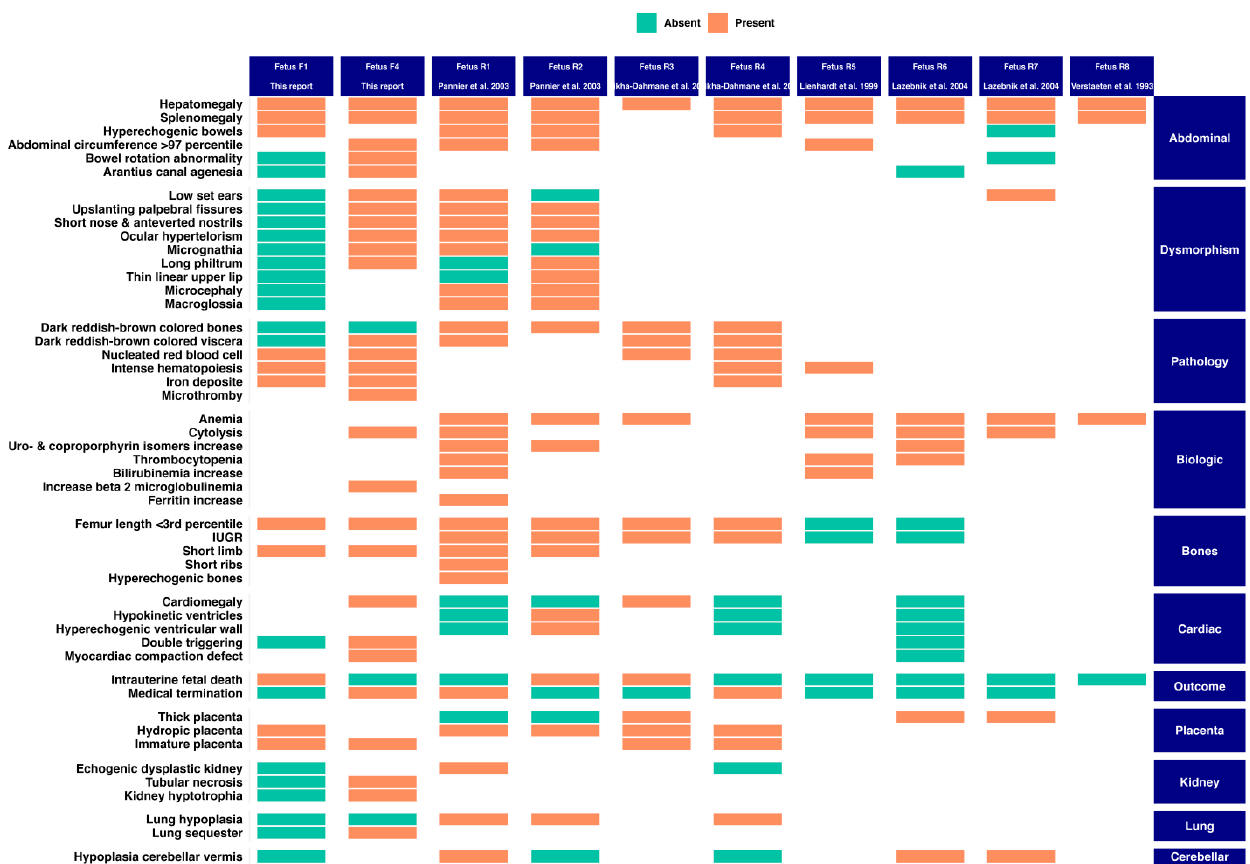
Figure 3. Overview of the clinical features of the two cases and the literature-reported cases